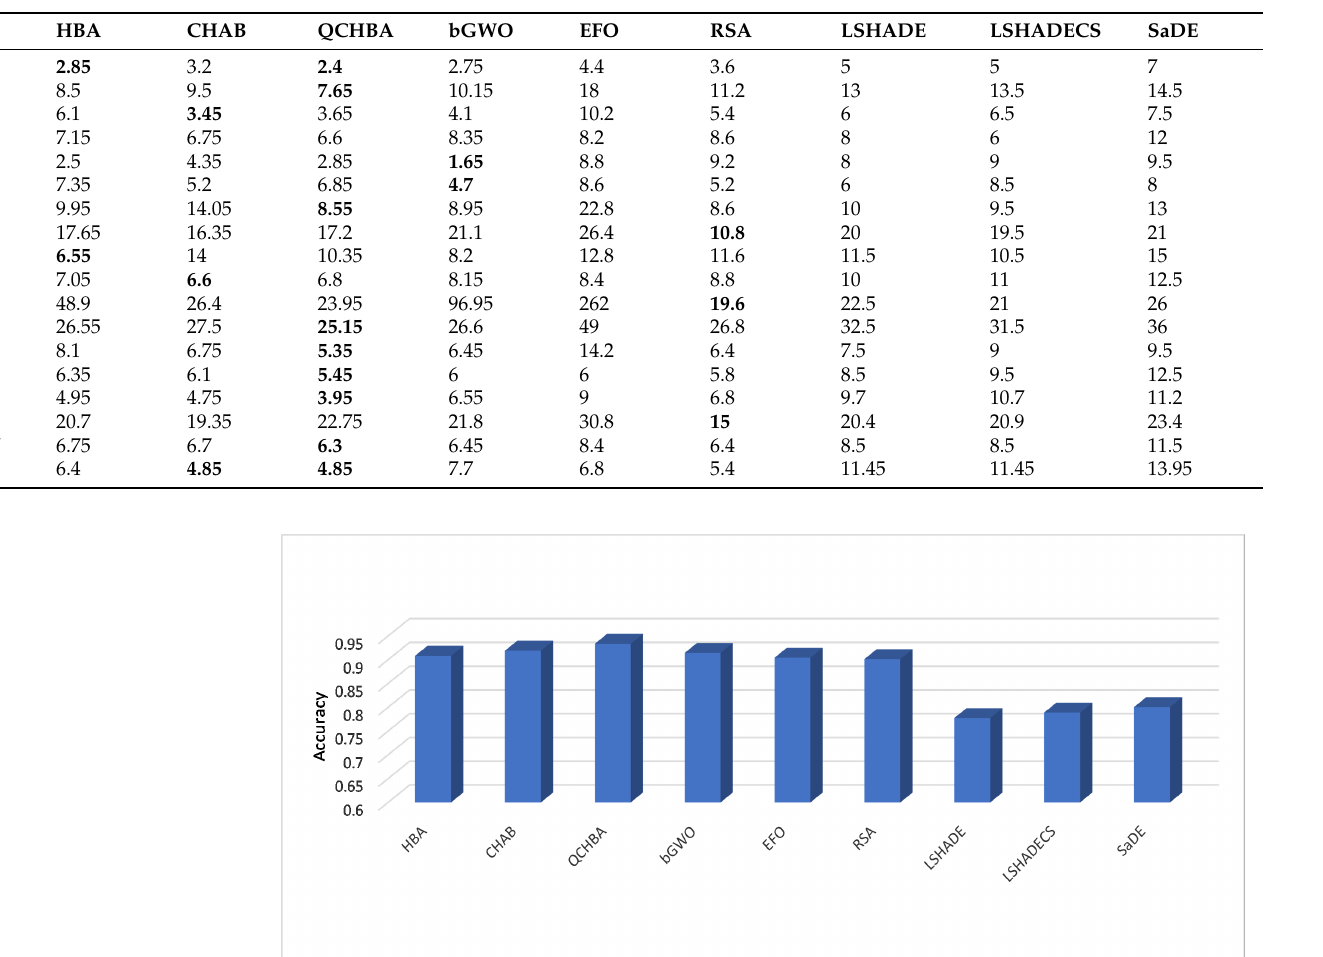
Figure 7. Performance of ACHBA and others based on the average